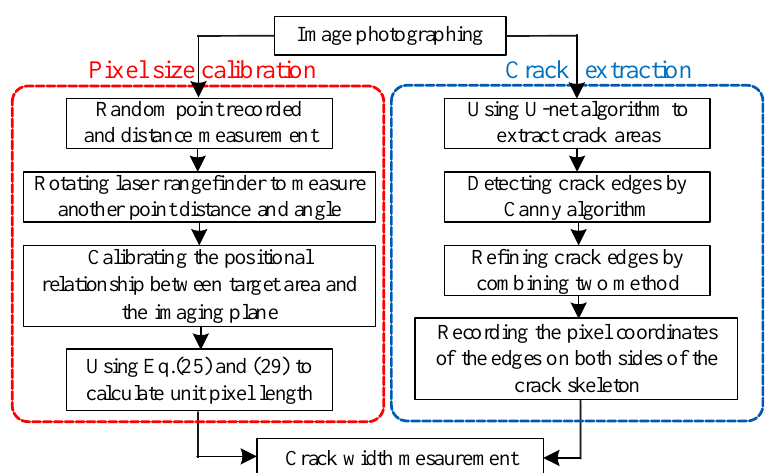
Figure 10. Flowchart of image-based concrete crack detection and measurement.